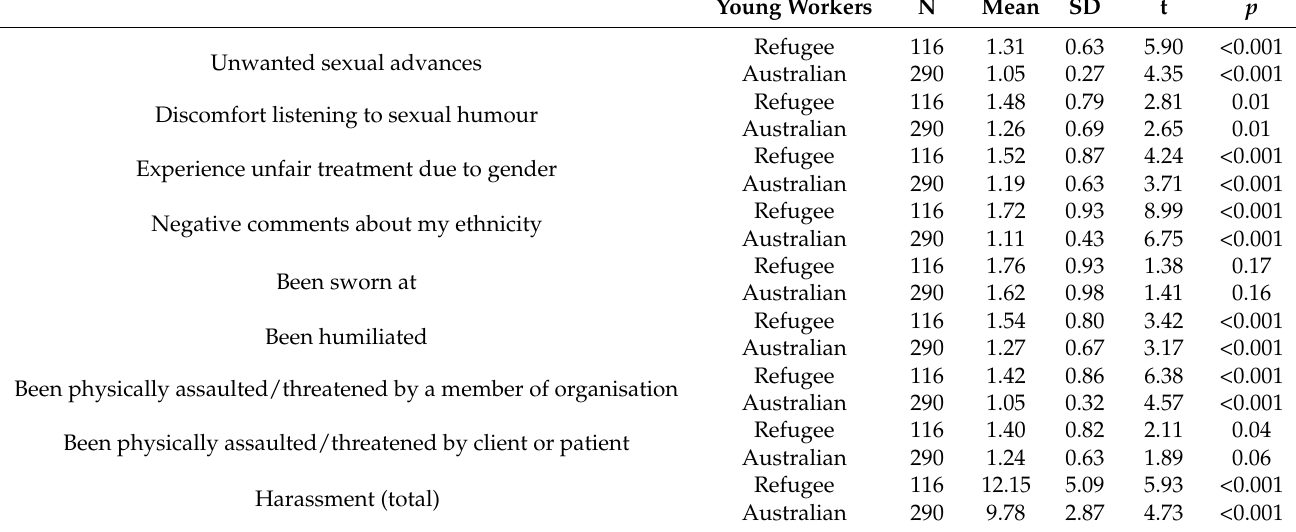
Note: degree of freedom ( df ) = 404.